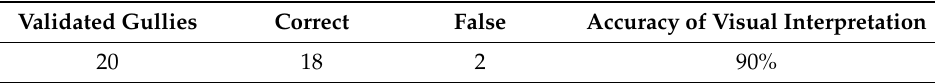
Table 3. Field validation results.